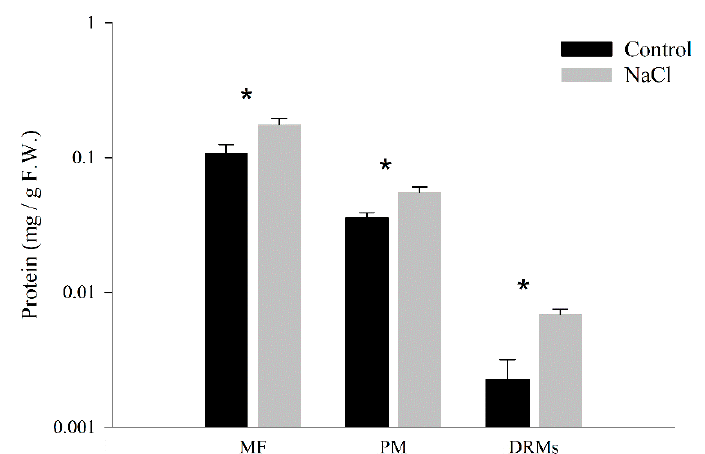
Figure 1. Protein concentration (mg g-1 FW) in microsomal fraction (MF), plasma membrane (PM) and detergent-resistant membranes (DRMs) from broccoli roots treated with 0 (control) and 80 mM NaCl. Data are means ± SE ( n = 5). Analyses were done with three biological samples. Asterisks (*) represent significant differences according to t-test for each fraction ( p < 0.05).